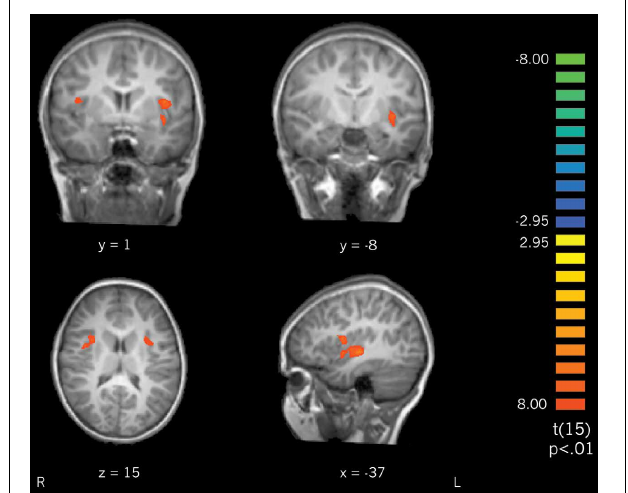
FIGURE 6 | A contrast of perception of actively learned letters > passively learned letters resulted in recruitment of bilateral insula and